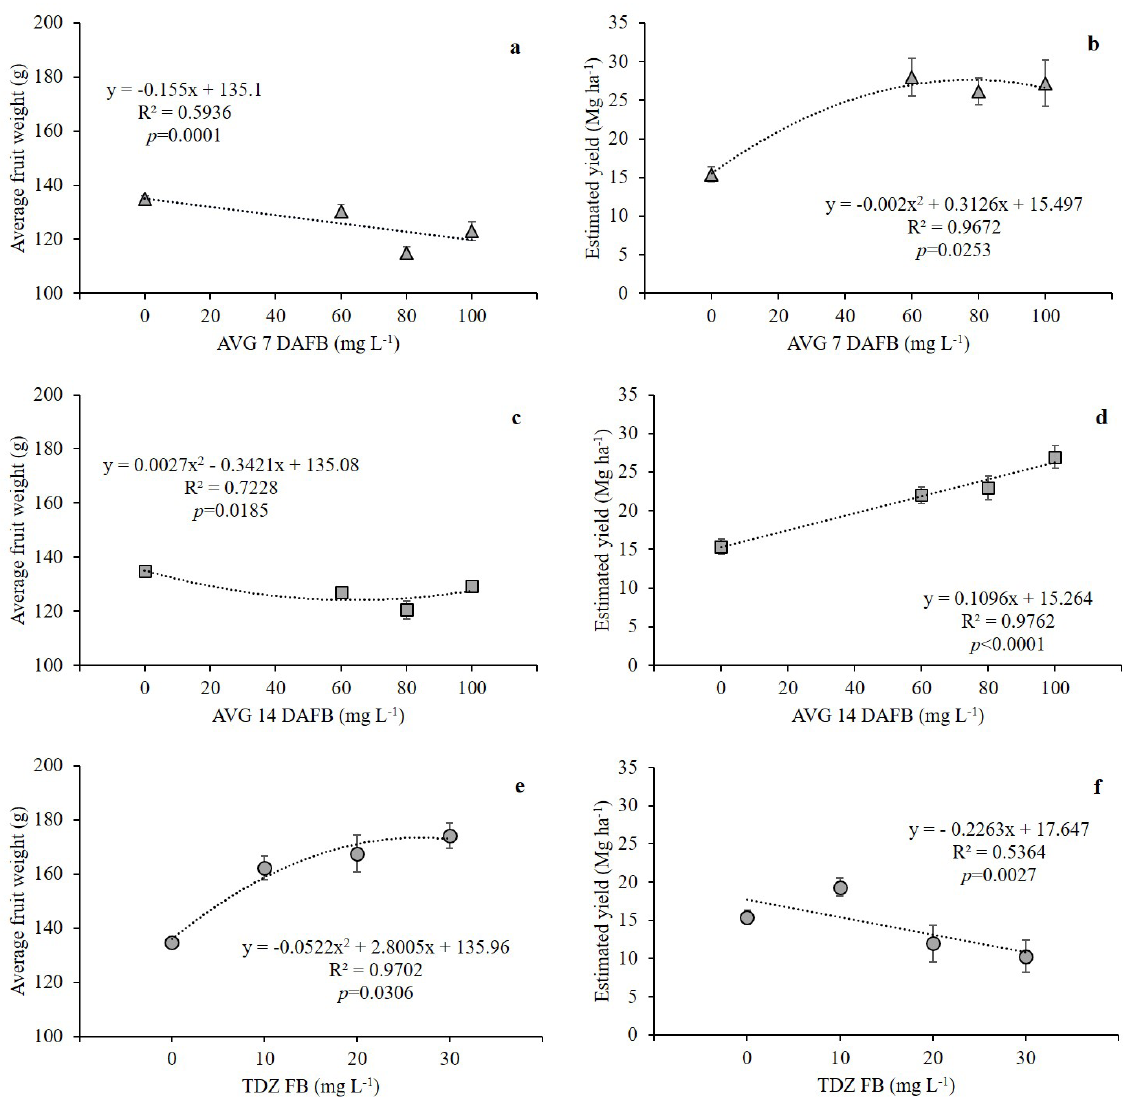
Figure 3. Average fruit weight (a, c and e) and estimated yield (b, d and f) of ‘Rocha’ pear trees subjected to aminoethoxyvinilglycine (AVG) at 7 days after full bloom (DAFB) (a and b), 14 DAFB (c and d) and thidiazuron (TDZ) at full bloom (FB) (e and f) in Antônio Prado, RS on 2016/2017 growing season. Vertical bars represent standard